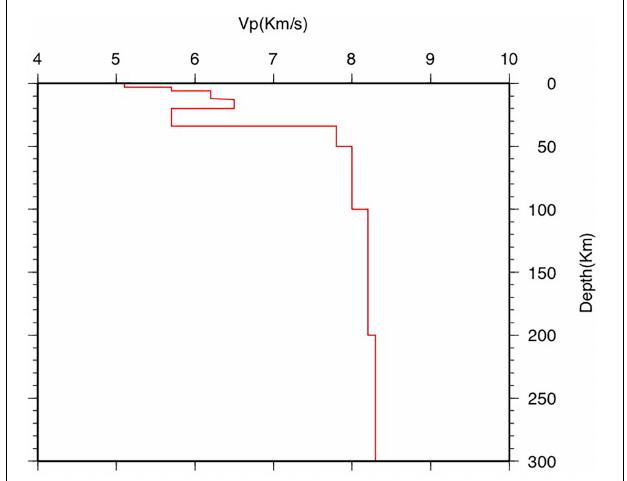
FIGURE 2 | The 1D P-wave velocity model used in the routine location of earthquakes.